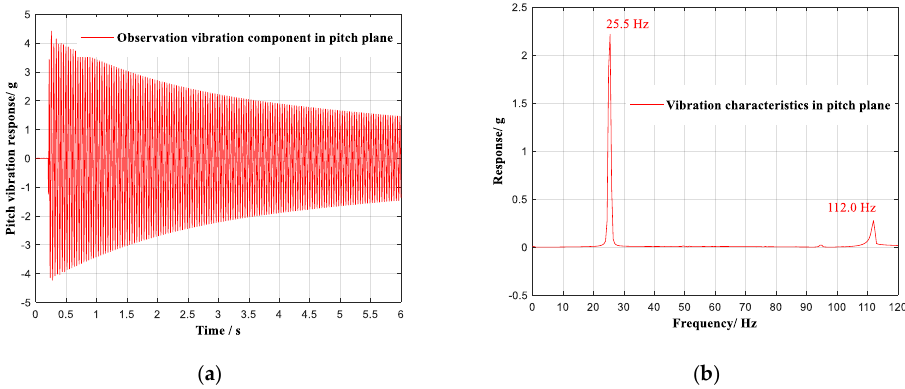
Figure 7. A selected stochastic vibration. ( a ) Response in the time domain. ( b ) Response in the frequency domain.